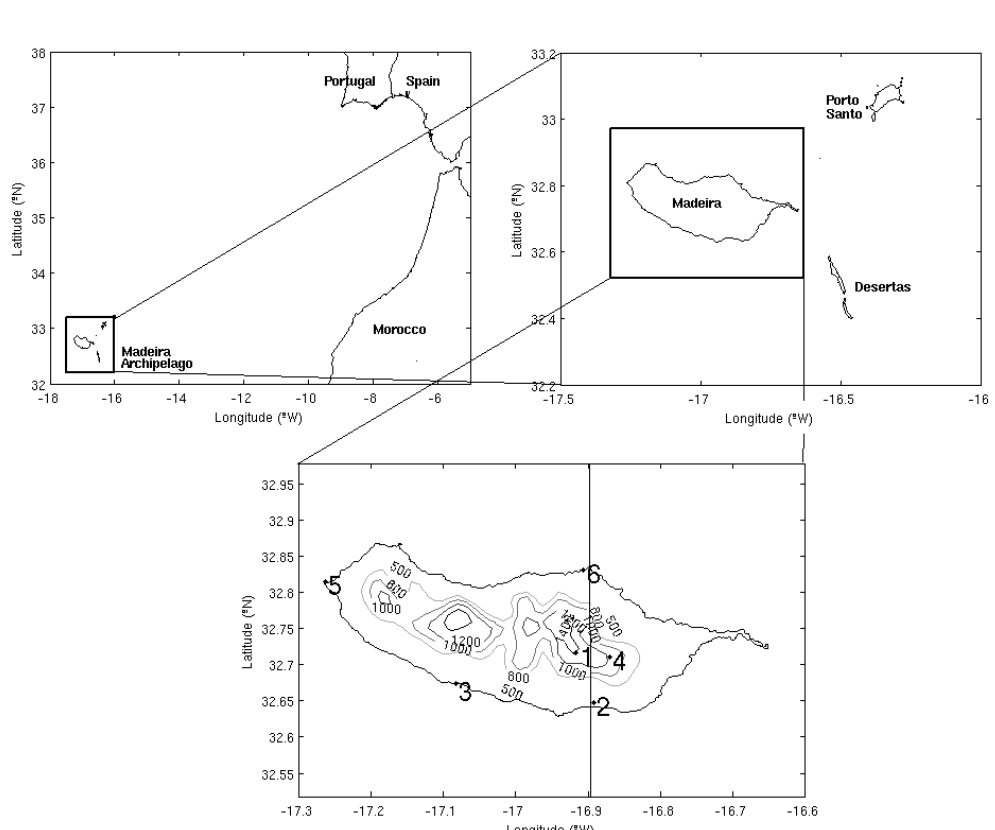
Fig. 1. Map of the Madeira archipelago location in the Atlantic Ocean, showing Madeira, Porto Santo and Desertas Islands. Madeira topography is shown with the location of weather stations used to evaluate the simulated precipitation described in Table 2, as well the location of the cross section used in this work.